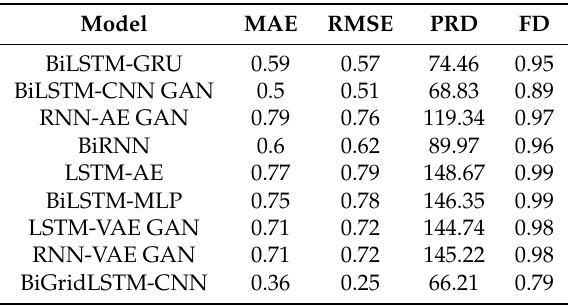
Table 4. Evaluation Metric Comparison with Existing